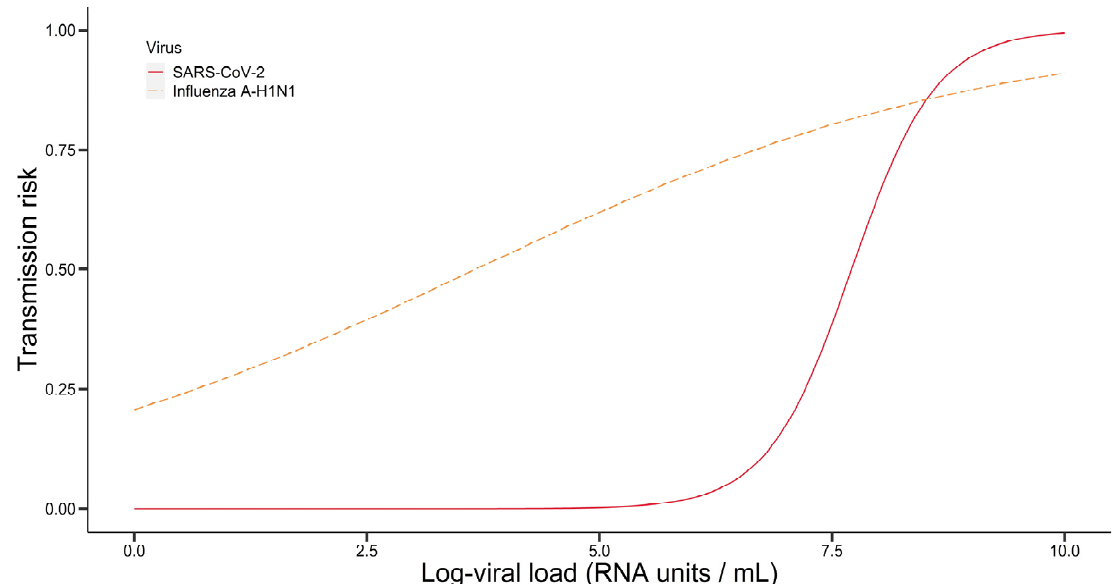
Figure 3. Viral transmission risk by log viral load (in RNA copies/mL) for SARS-CoV-2 (red solid) and influenza A-H1N1 (orange dashed).